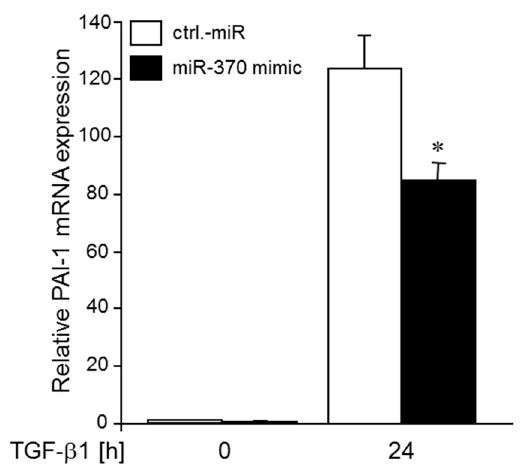
Figure 8. Ectopic expression of a miR-370-3p mimic partially rescues Colo357 cells from the TRAIL-R1 shRNA-induced TGF β 1 hyperstimulation of PAI-1 expression. Colo357 cells with stable expression of a TRAIL-R1 shRNA were transiently transfected with 50 nM of control (ctrl.) miR or a miR-370-3p mimic and 48 h later stimulated with TGF β 1 (5 ng/mL) for 24 h. Data represent the mean ± SD of three independent experiments ( n = 3). The asterisk (*) indicates significance relative to control ( p <